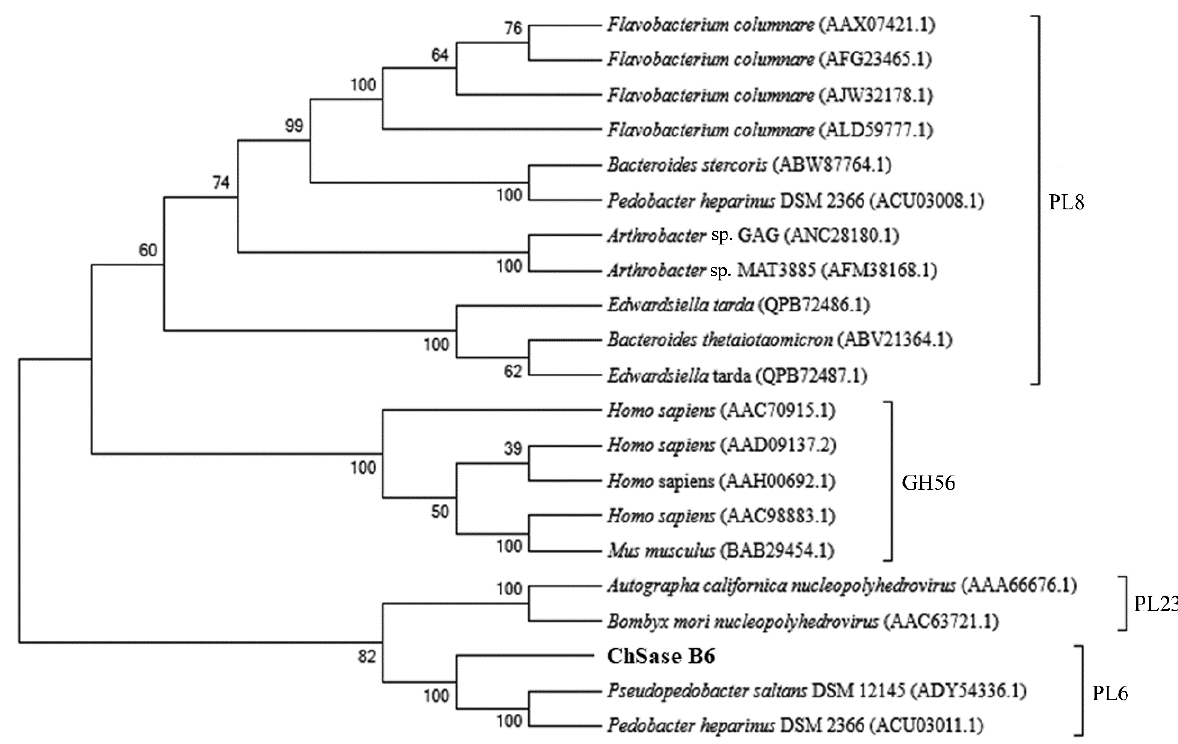
Figure 1. Phylogenetic analysis of ChSase B6. The phylogenetic tree was constructed with MEGA 7.0 using the neighbor-joining method.